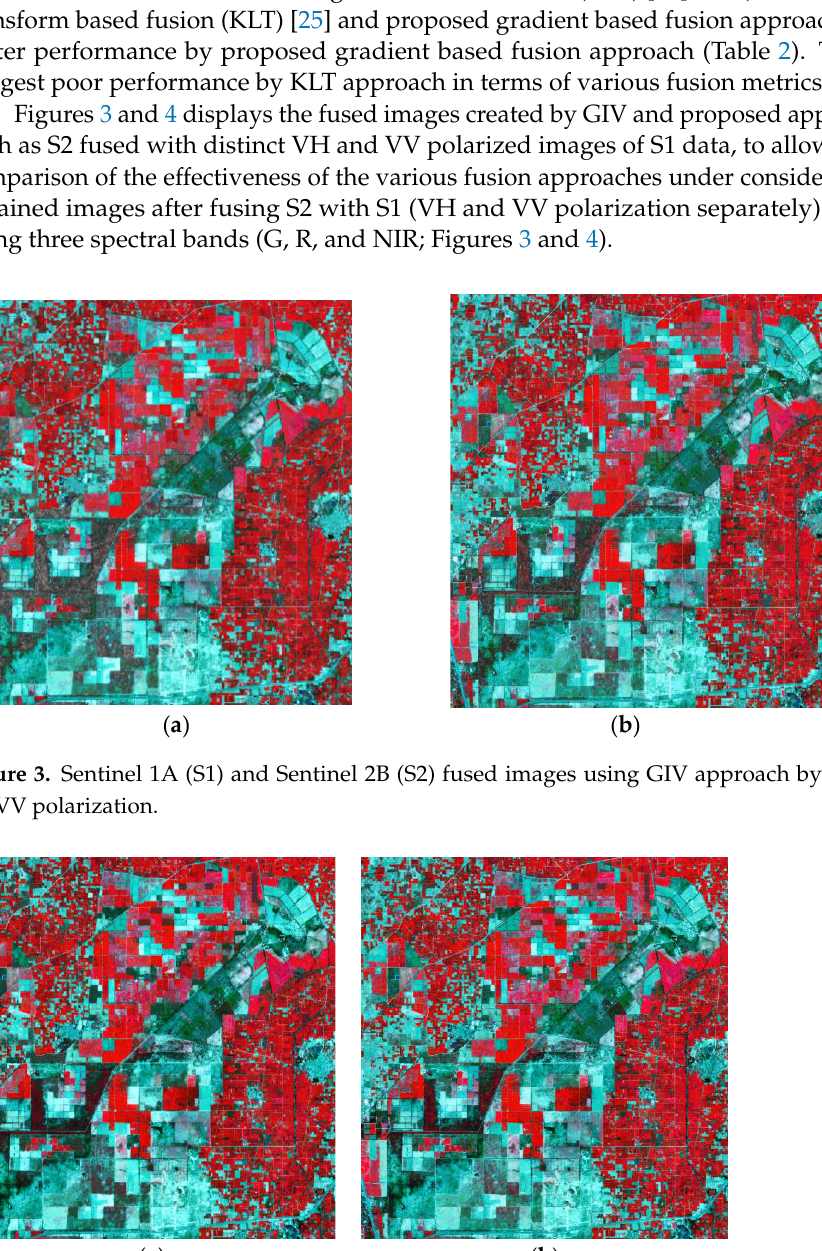
Table 2. Assessment of the Fusion Metrics of Hissar, Haryana (India).